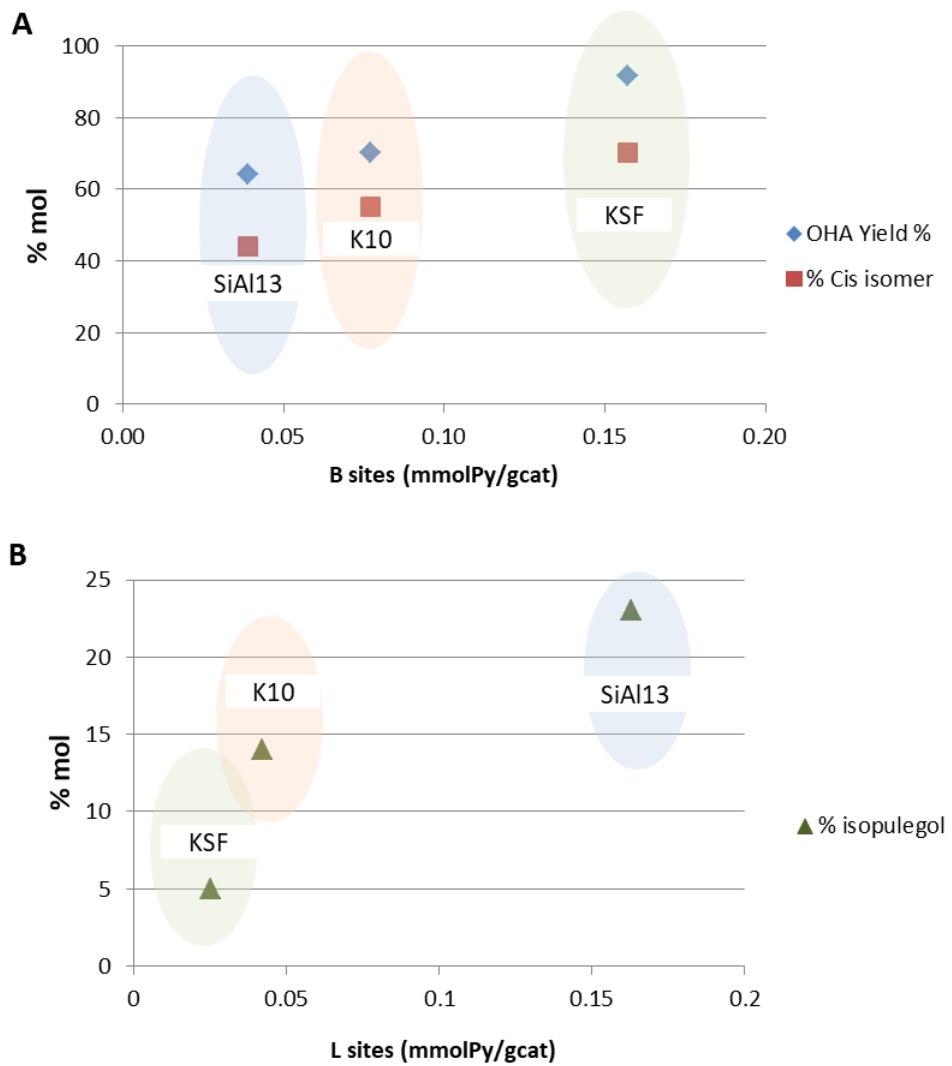
Figure 2. Trend in products distribution versus the concentration of B acidic sites ( A ) and L sites ( B